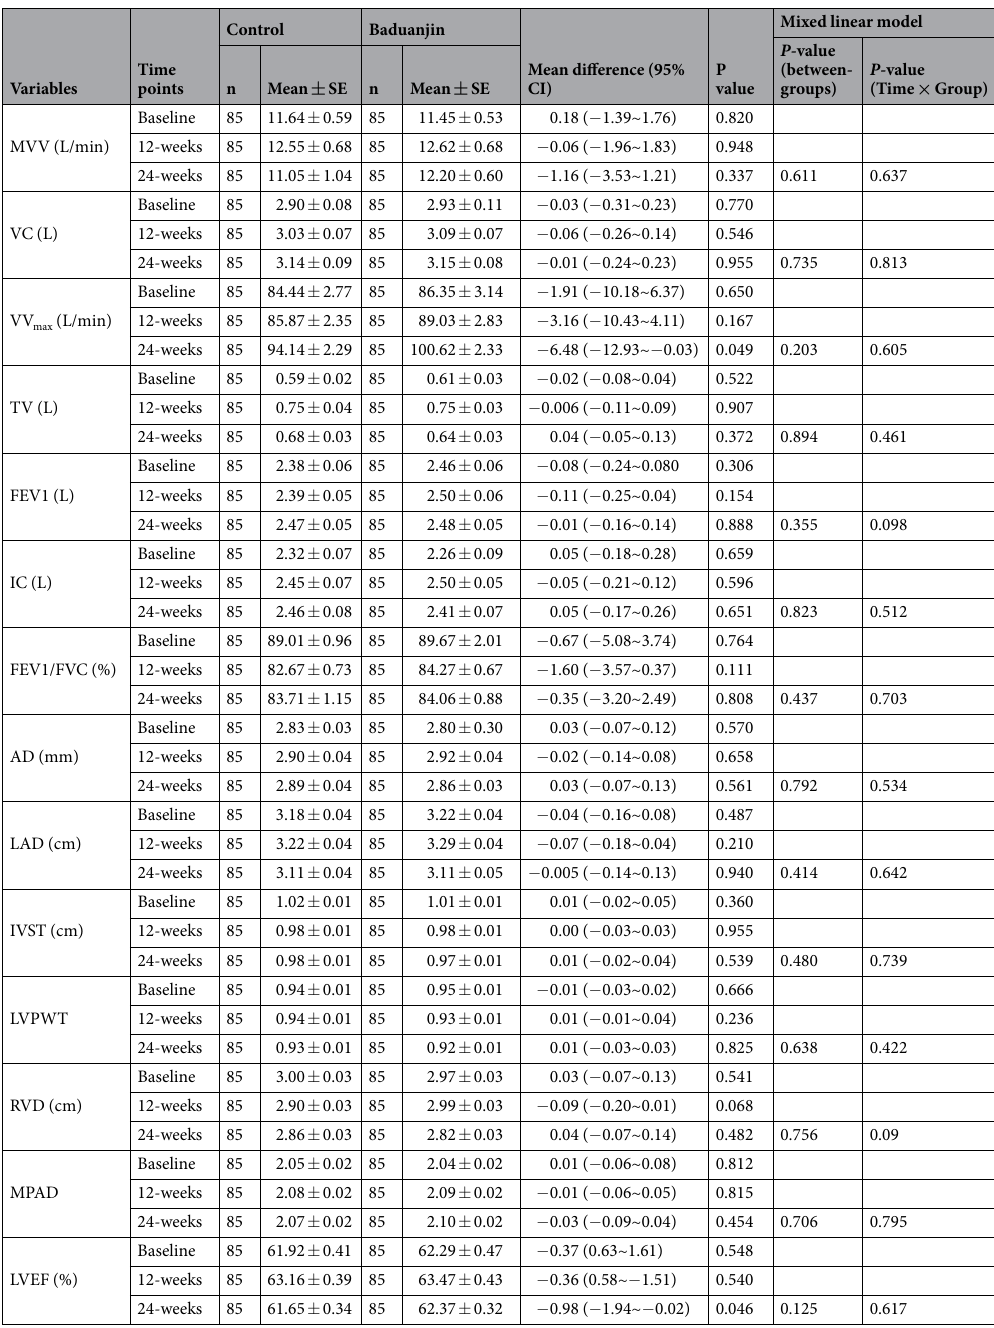
Table 4. Mean cardiopulmonary function outcomes at all time points (Mean ± SE). Abbreviations: MVV: Minute ventilation volume; VC: Vital capacity; VV max : Maximal voluntary ventilation; TV: Tidal volume; FEV1: Forced expiratory volume in one second; IC: Inspiratory capacity; FVC: Forced vital capacity; AD: Aortic diameters; LAD: left atrial diameter; IVST: Interventricular septal thickness; LVPWT: left ventricular posterior wall thickness; RVD: right ventricular diameter; MPAD: main pulmonary artery diameter; LVEF: Left ventricular ejection